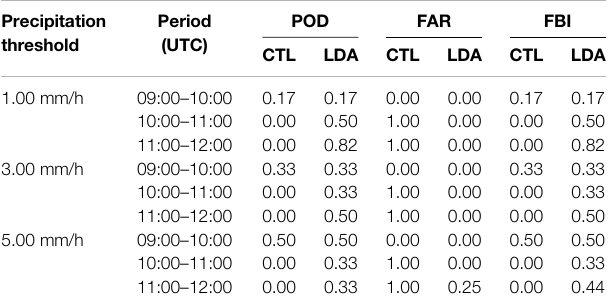
TABLE 1 | Forecast skill scores of accumulative precipitation forecast at different thresholds for the control experiment (CTL) and the lightning assimilation experiment (LDA),